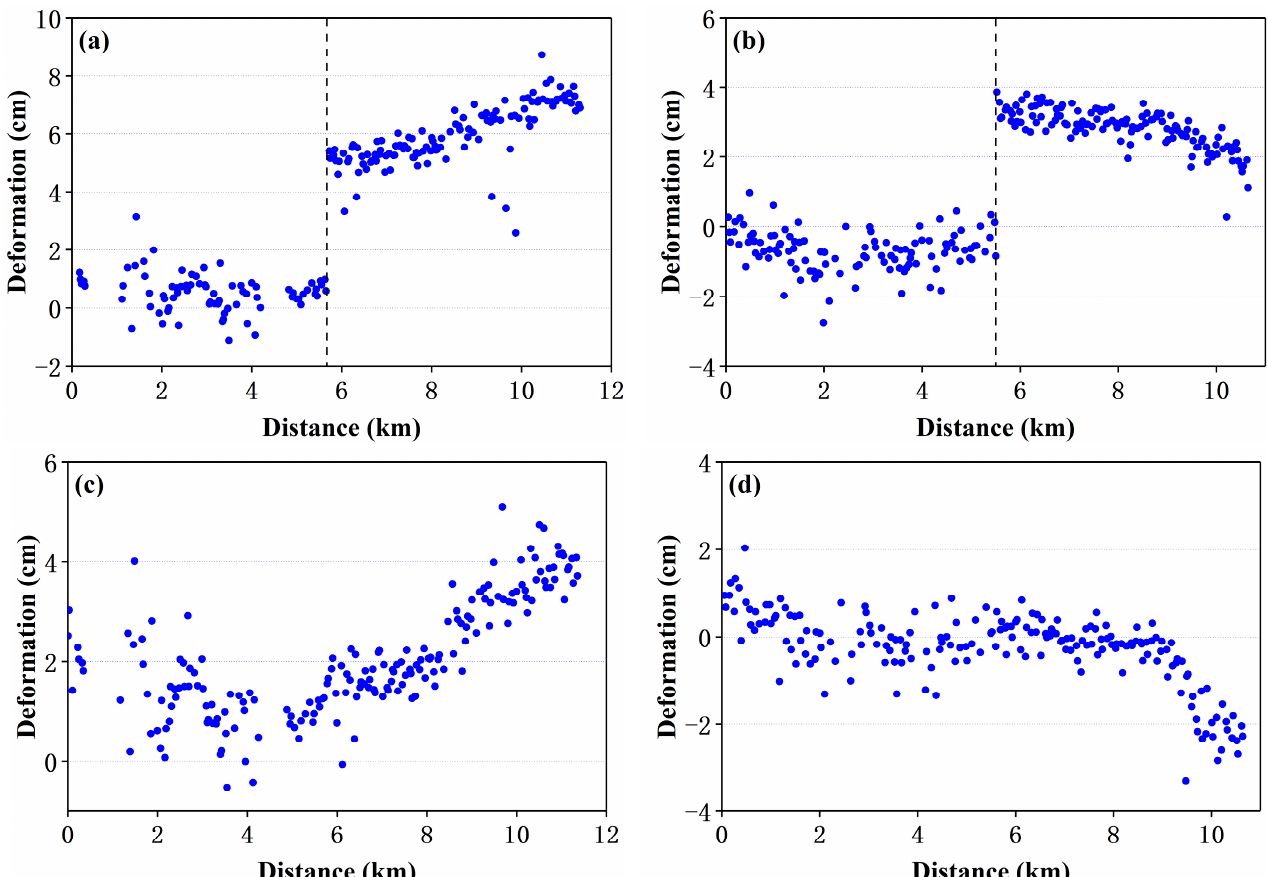
Figure 6. Velocity from 2005 to 2010 along Profiles 1 and 2 shown in Figure 5. ( a , b ) are the results before correction; ( c , d ) are the results after correction by USLS.